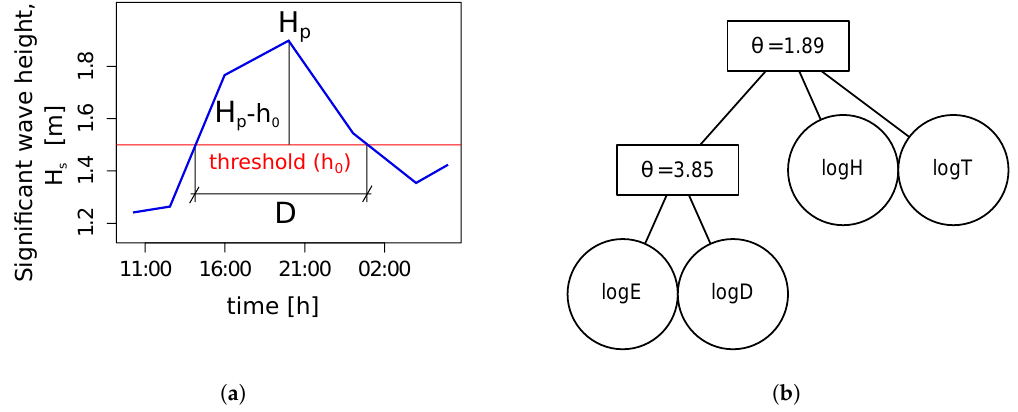
Figure 3. ( a ) Schematic view of the definition of a wave-storm. The blue thick line represents a wave, the red thin line represents a wave-storm threshold of value h 0 . ( b ) Hierarchical Archimedean copula (HAC)-structure-tree at node 13, in the period 2001–2050, under the RCP4.5 scenario. The circles contain the names of the storm components, which are bound together by a dependence-parameter, written in the rectangles ( θ ∈ [ 0, ∞ ) ). This HAC-structure-tree comes from the stationary statistical model. It is representative of all nodes, at each time-window of 50 years and in both emission scenarios. Then, it is selected to represent the dependence-structure of the whole non-stationary statistical